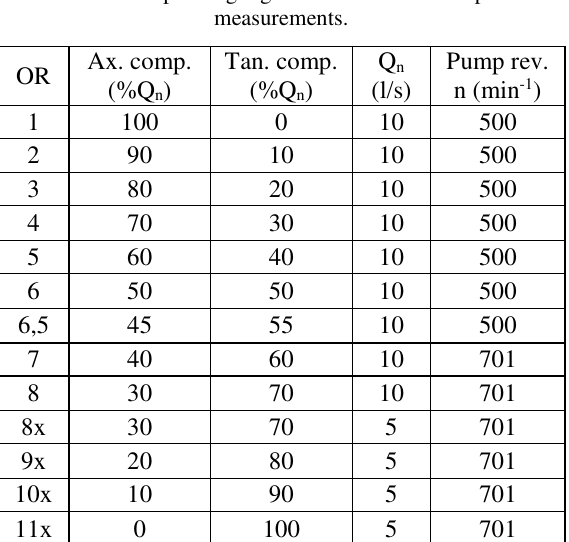
Tab. 2. Operating regime of cross-sectional plane measurements.